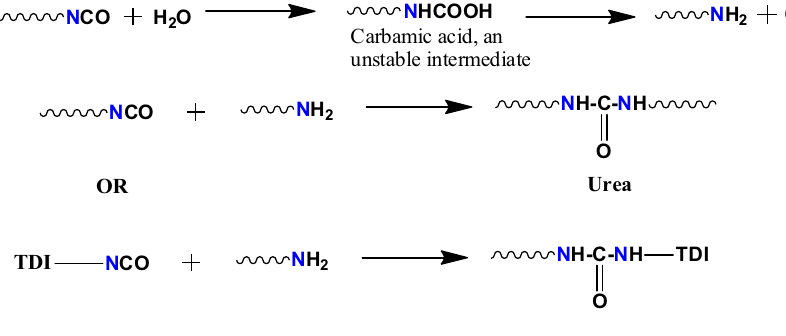
Scheme 4: Curing